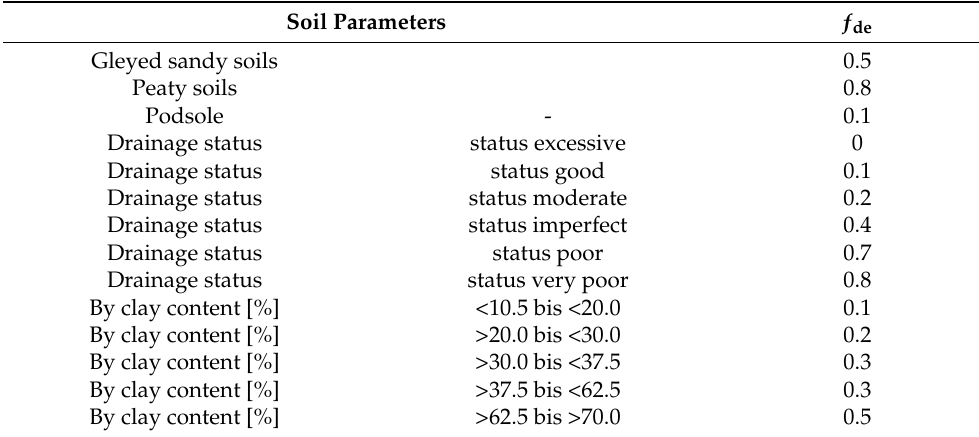
Table 12. Matrix for determining denitrification factors and clay content classes [10,11]. Soil Parameters ƒ de